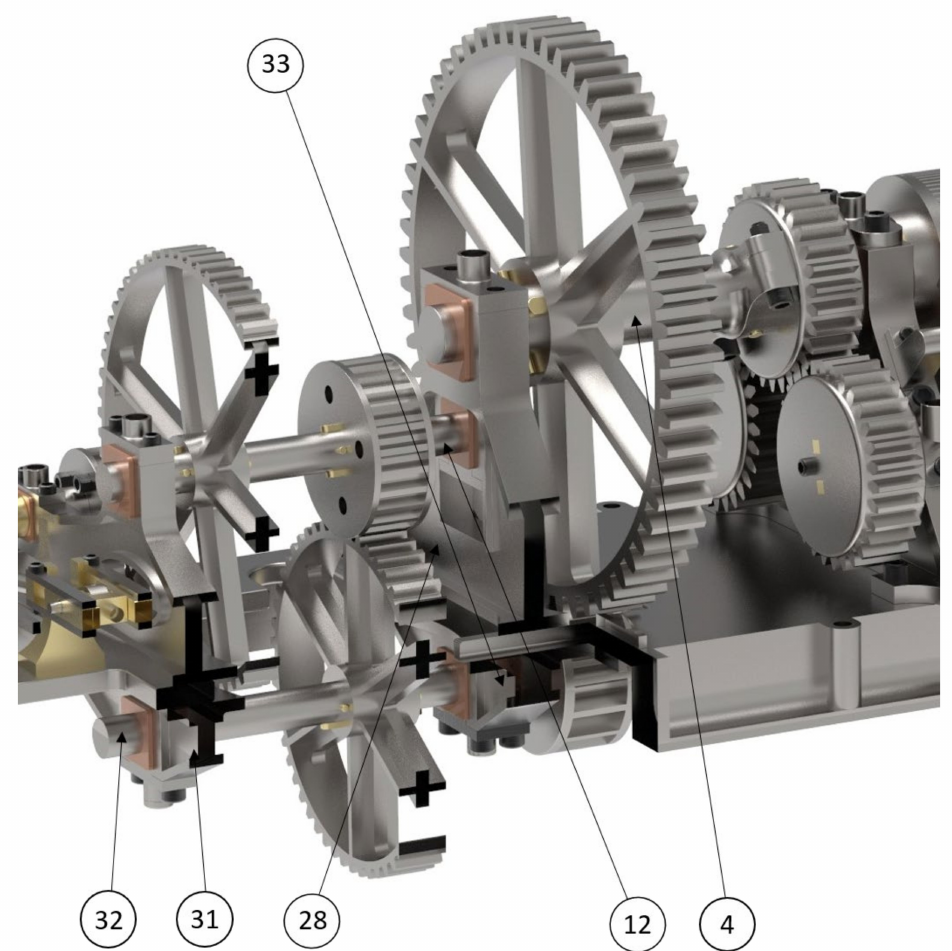
Figure 7. View of the gear train assembly, with cut-out in the lower